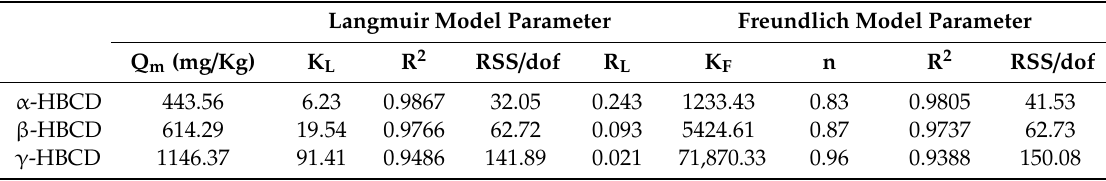
Table 1. Isotherm parameters for HBCDs sorption on sediment.